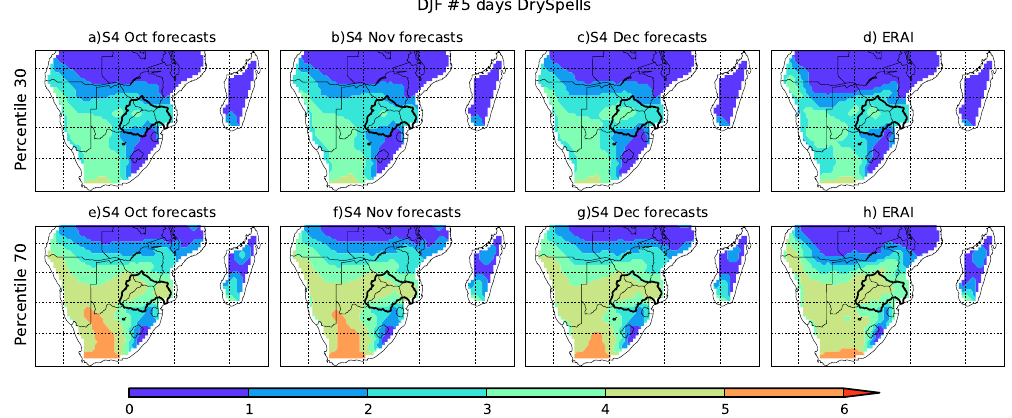
Fig. 4. Climatology of the DJF frequency of occurrence for 5-day dry spells. (a) – (d) show the 30th percentile and (e) – (h) the 70th percentile. From left to right ECMWF S4 forecasts initialized in October (a, e) , November (b, f) and December (c, g) and from ERA-Interim (d, h)